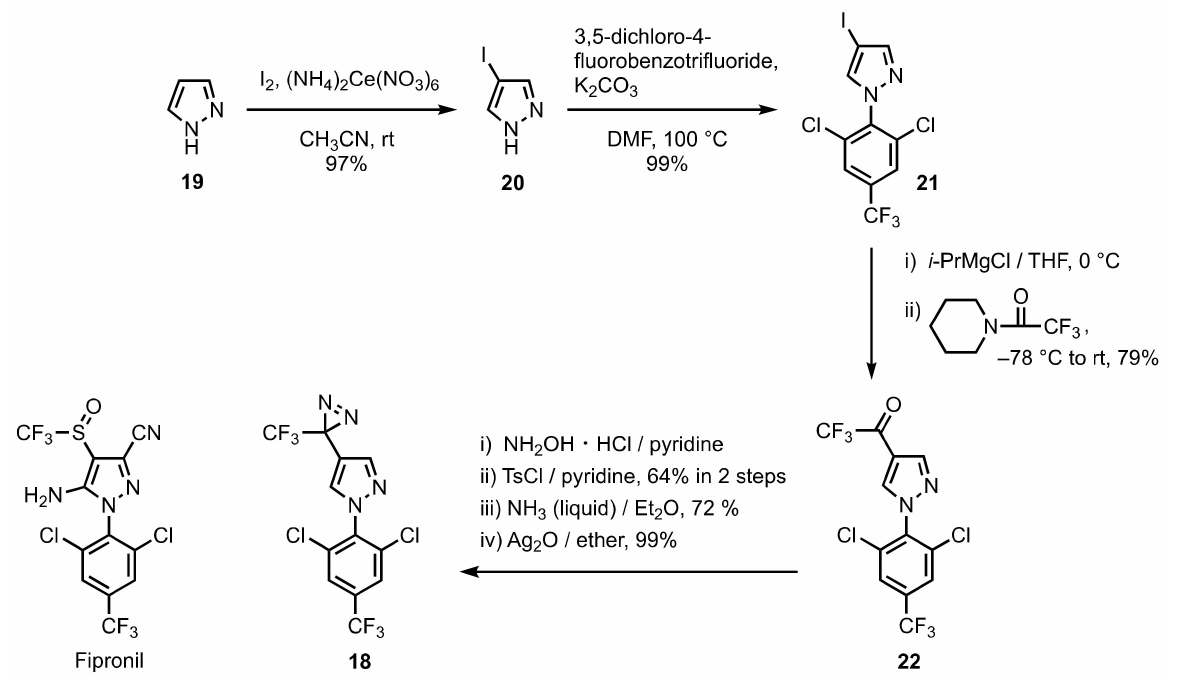
Scheme 4. The synthesis of diazirinyl fipronil based on benzimidazole skeleton